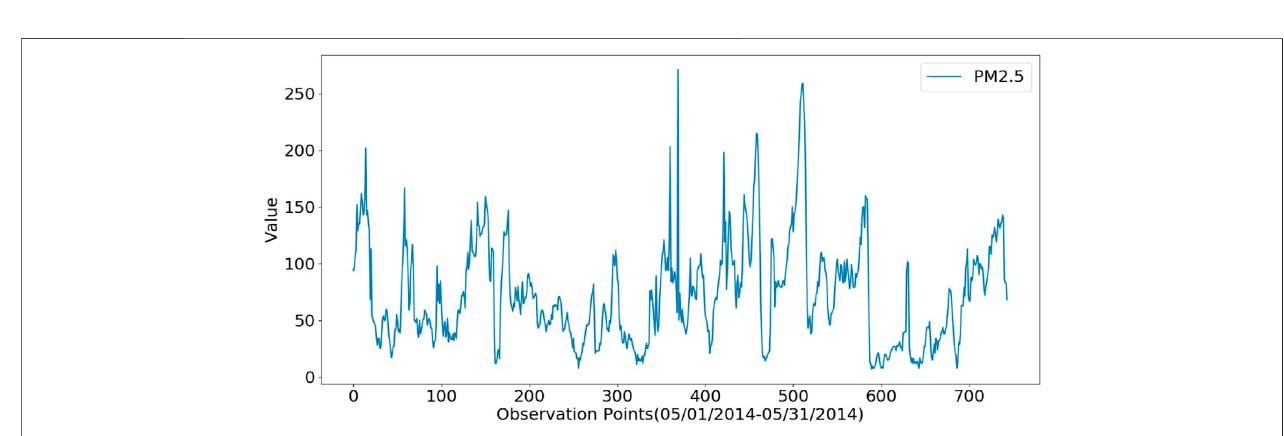
FIGURE 2 | An illustration of hourly PM2.5 values (ug/m 3 ) from 5/01/2014 to 5/31/2014 on Beijing PM2.5 dataset [Each observation point in the horizontal axis denotes a timescale (hour) related to the collected PM2.5 value, as described in the vertical axis in this fi gure].